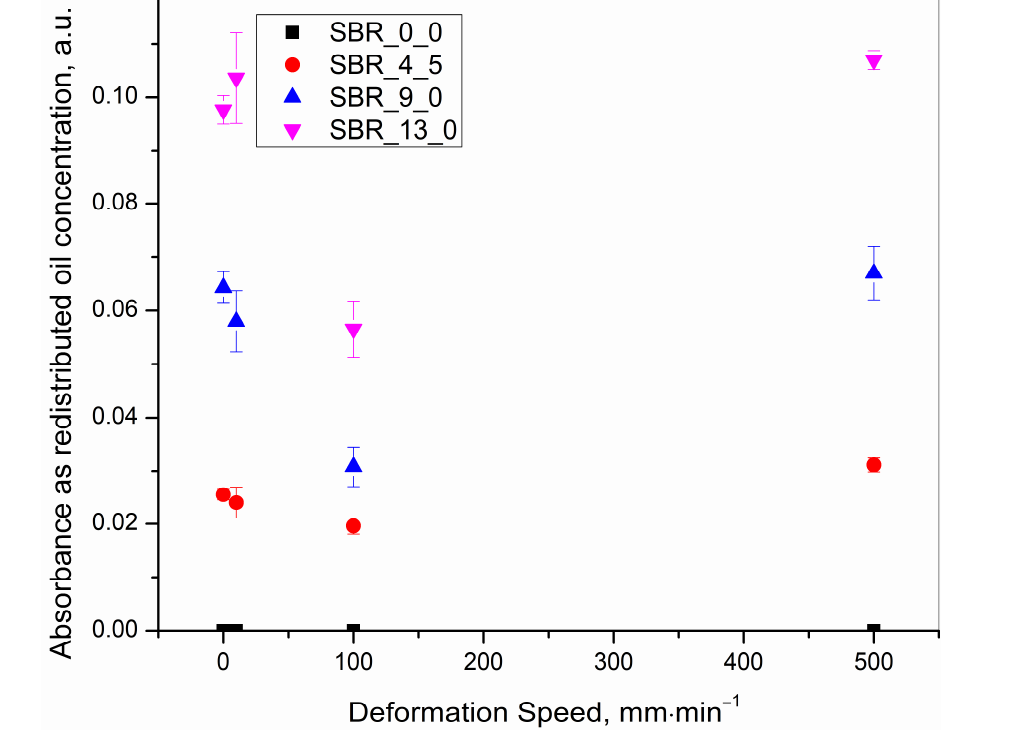
Figure 6. Calculated IR absorbance peak height at 2915 cm −1 representing the redistributed oil concentration after rupture as a function of deformation speed for 0.0, 4.5, 9.0 and 13.5 phr of initial oil incorporated samples.